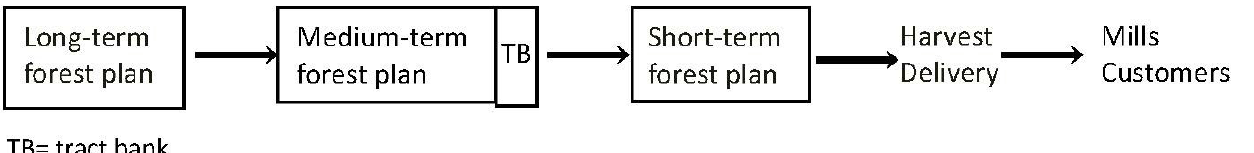
Figure 1. The forest planning hierarchy and its relationship to forestry activities and